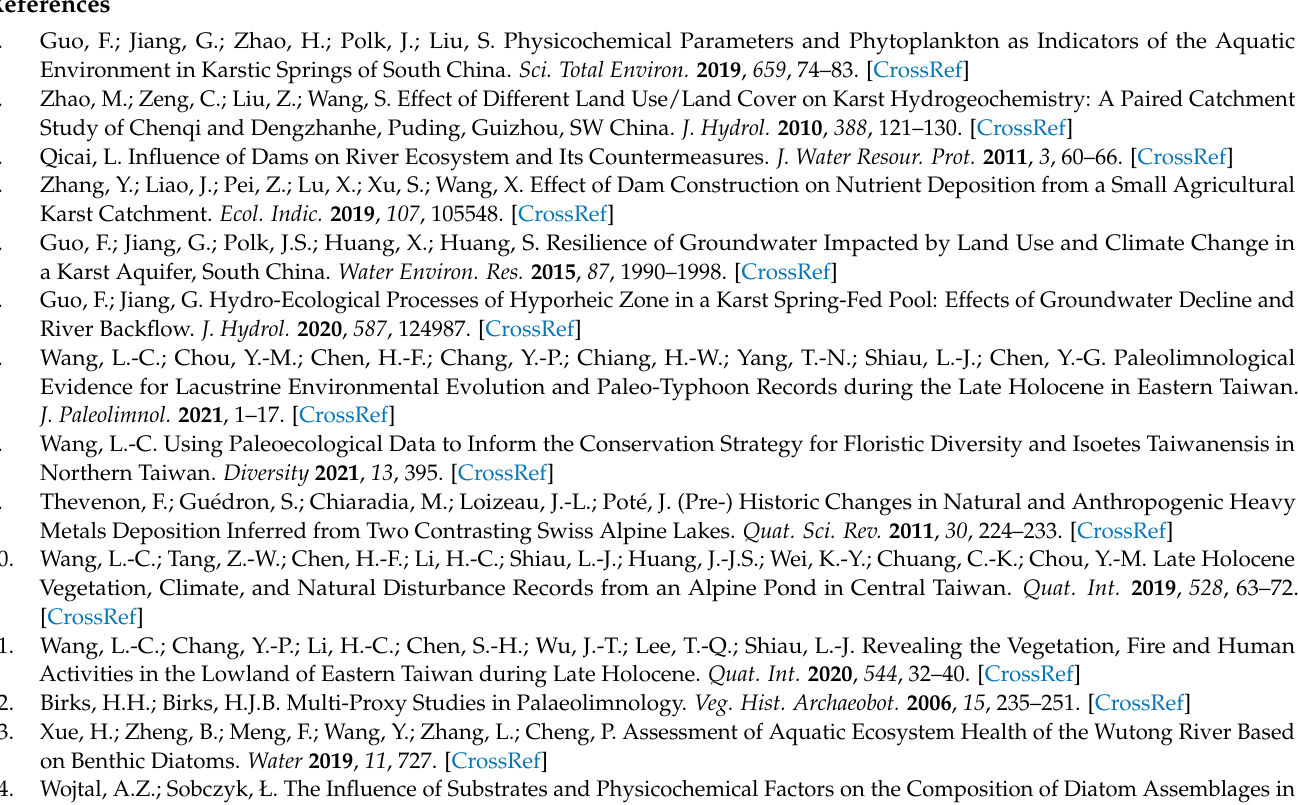
Table S2: Scores of PCA and environmental conditions for the selected diatom species in the Lingshui Pond sediment